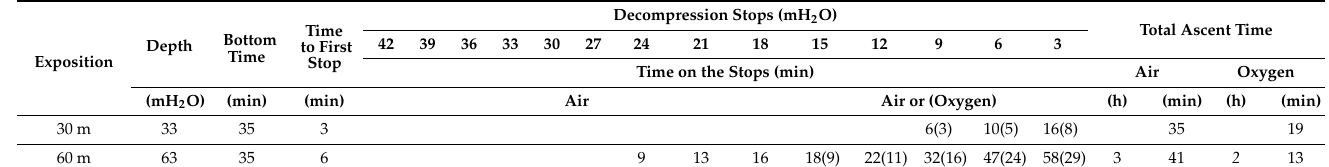
Table 1. 3 MW decompression tables.